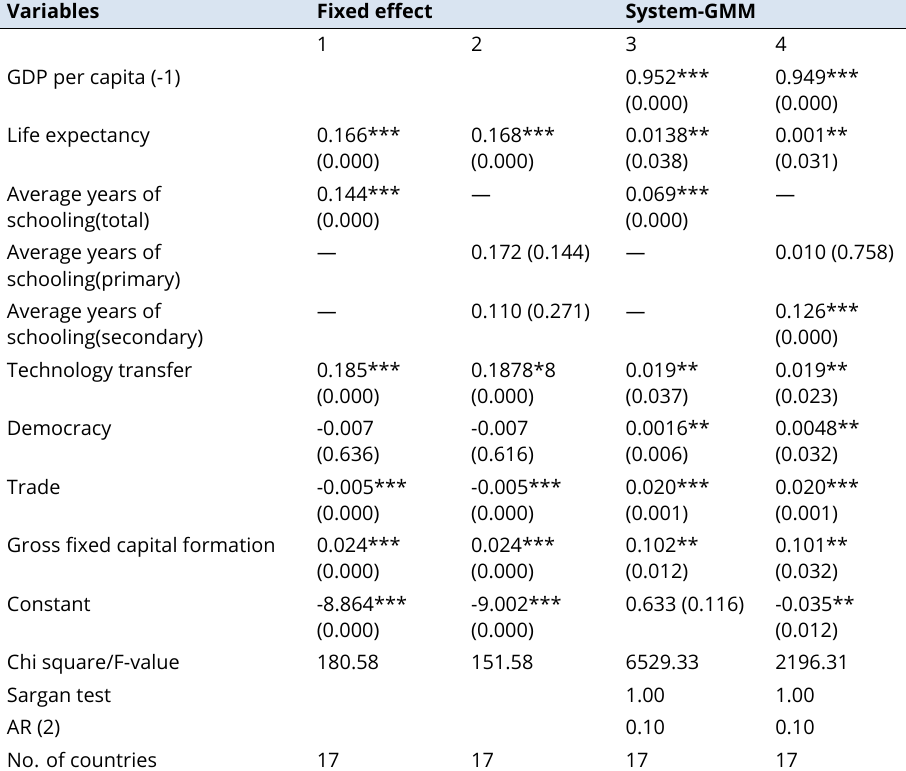
Human Capital & Technological Advancement (High income and